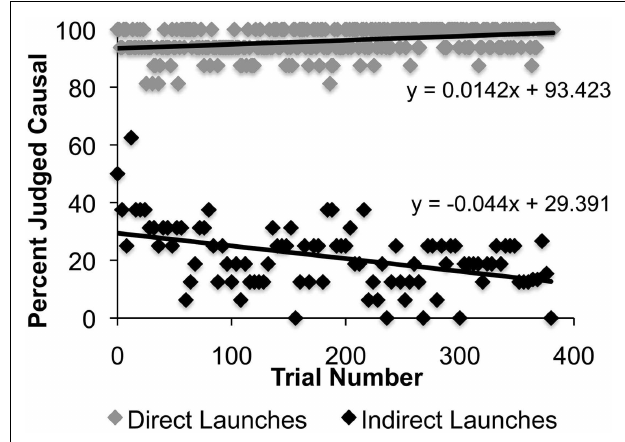
FIGURE 3 | Percent of trials judged causal as a function of trial number for direct and indirect trial types in Experiment 3. The positive trend line (slope = 0.014) for direct launches demonstrates that participants were slightly more likely to judge direct launching events as causal over the duration of Experiment 3. In contrast, the negative trend line (slope =− 0.04) for indirect launches demonstrates that participants were less likely to judge indirect launching events as causal over the duration of Experiment